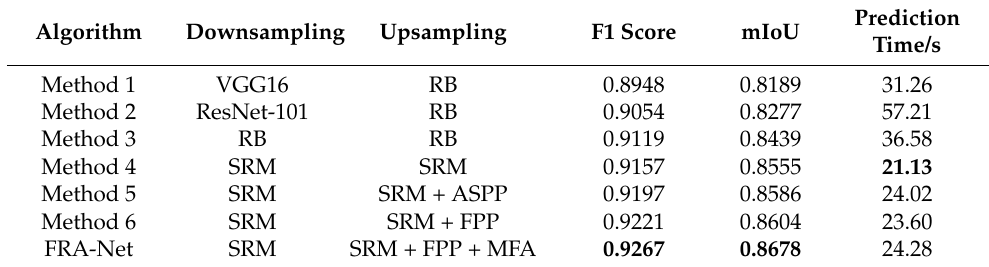
Table 3. Evaluation results of different sampling methods in the LandCover test